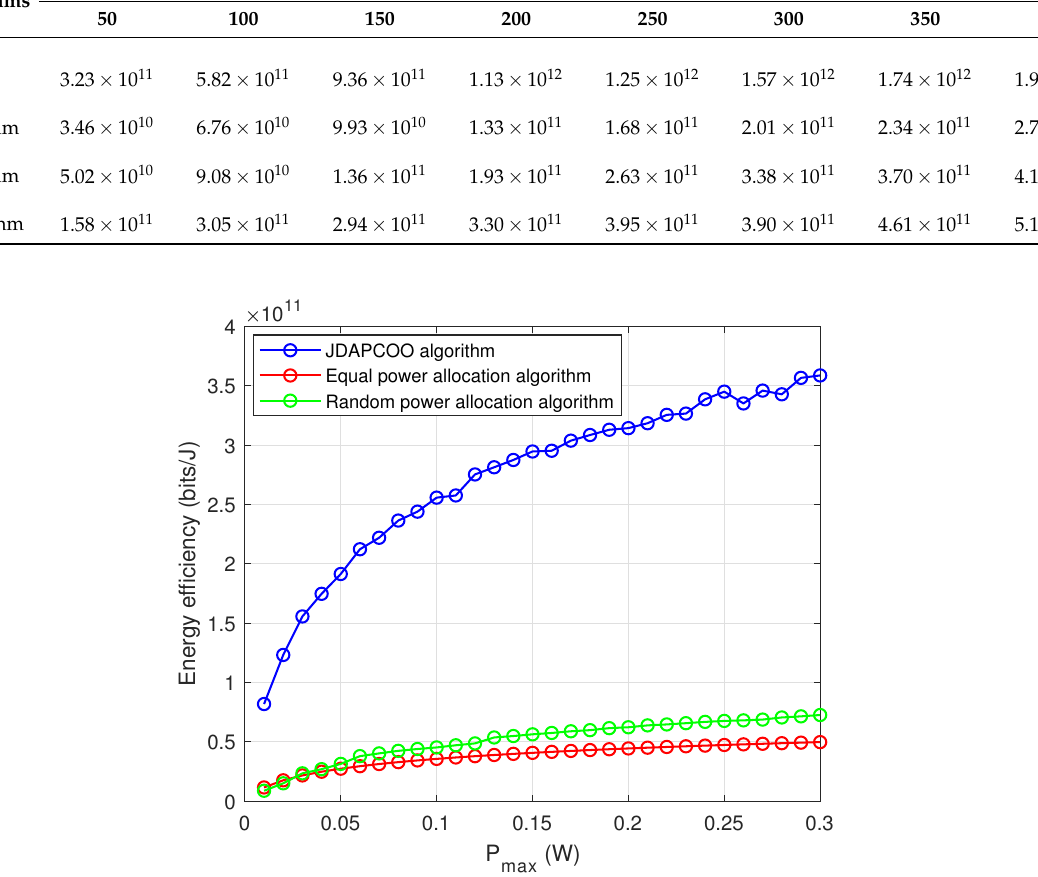
Figure 8. The relationship between the total system energy efficiency and the maximum